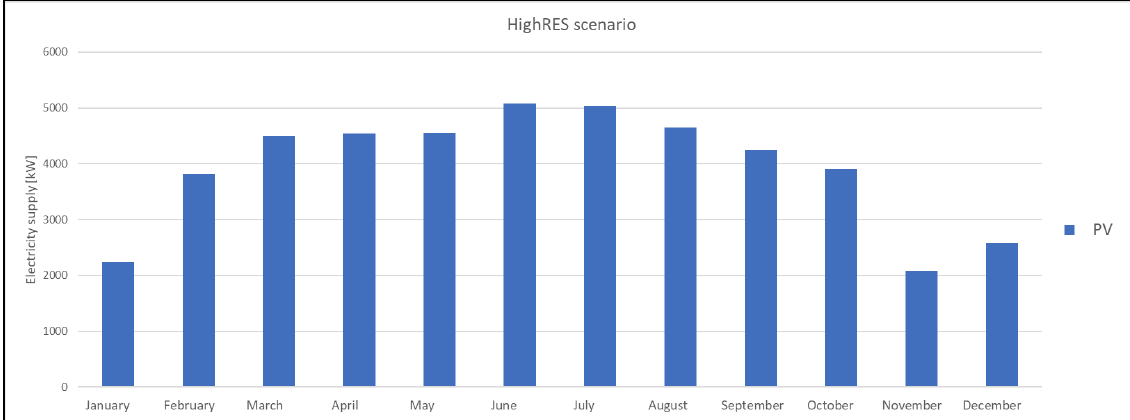
Figure 9. Average PV systems’ output power values for Scenario 3 .